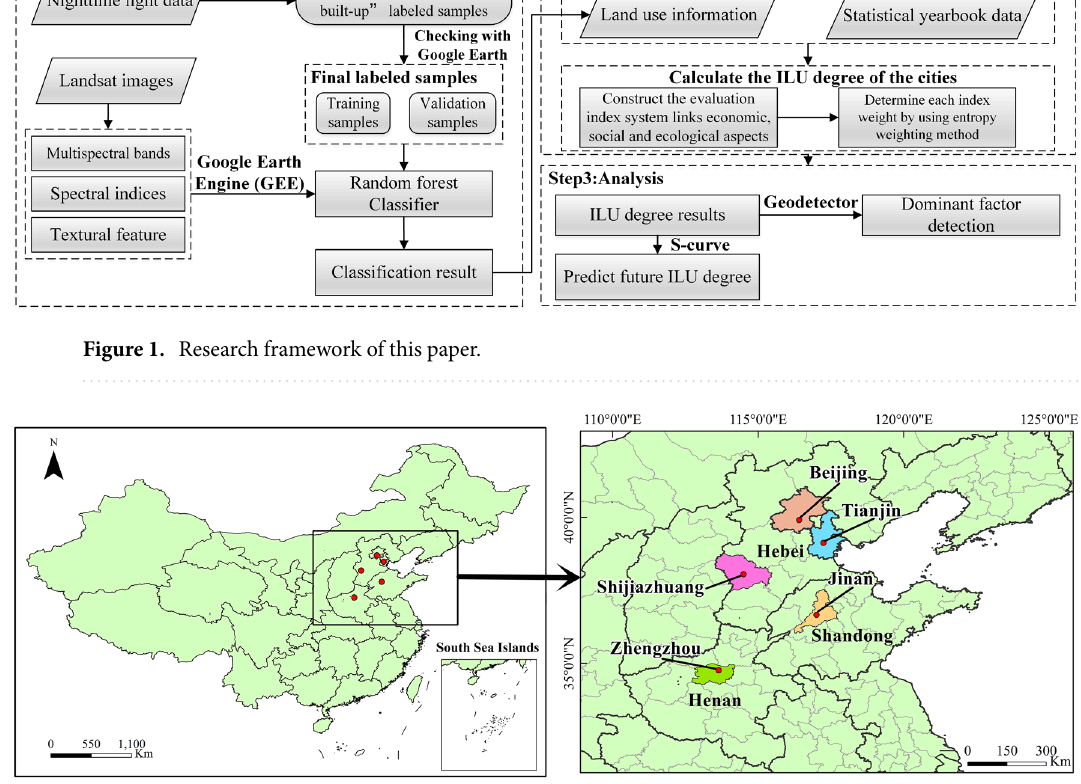
Figure 2. Spatial location of study area. Map created using